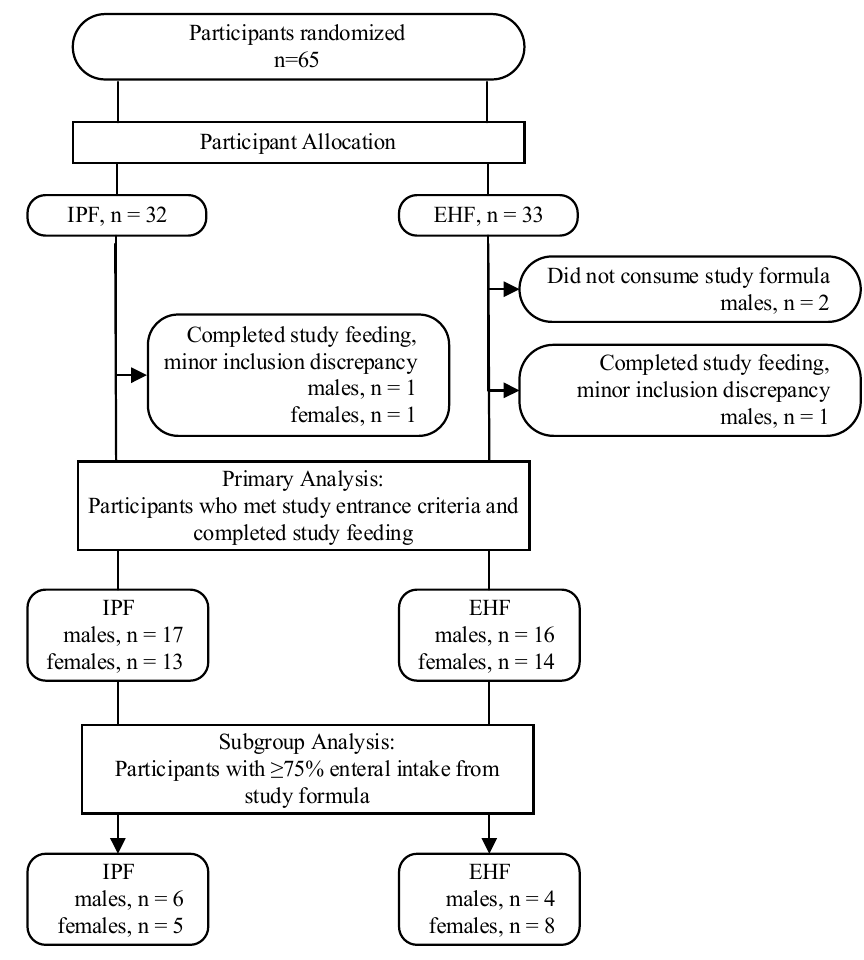
Figure 1. Study allocation.